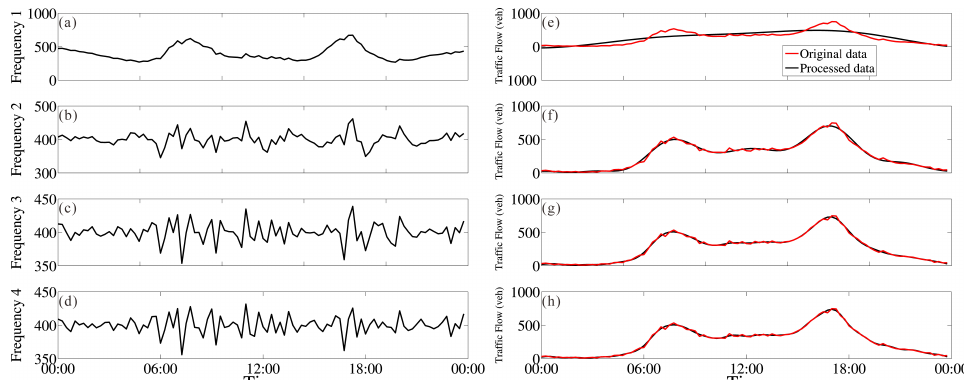
Figure 3. The original tra ffi c flow sequence